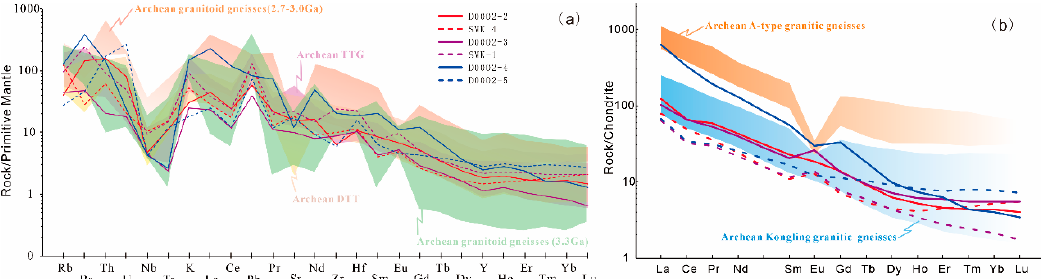
Figure 18. Primitive-mantle-normalized trace element distributions and chondrite-normalized rare earth element patterns in the Archean TTG and granite dikes from the Kongling terrane. Normalizing values are from [39]. The red and purple lines are for Kongling TTGs (D0002-2 and SMK-4 for tonalitic gneiss, and D0002-3 and SMK-1 for trondhjemite gneiss), and the blue lines are for granite dikes (D0002-4 and D0002-5). Data for the Archean granitoid gneisses, Archean TTG, and Archean DTT are from Gao et al. [7], Guo et al. [13], and Guo et al. [16], respectively for the Archean TTG and granite dikes from the Kongling terrane. ( a ) Primitive-mantle-normalized trace element distributions diagram; ( b ) Chondrite-normalized rare earth element patterns diagram.